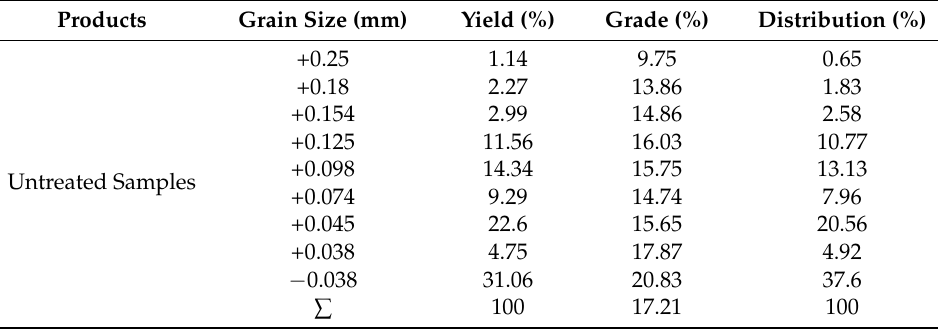
Table 5. Ilmenite distribution in untreated samples.